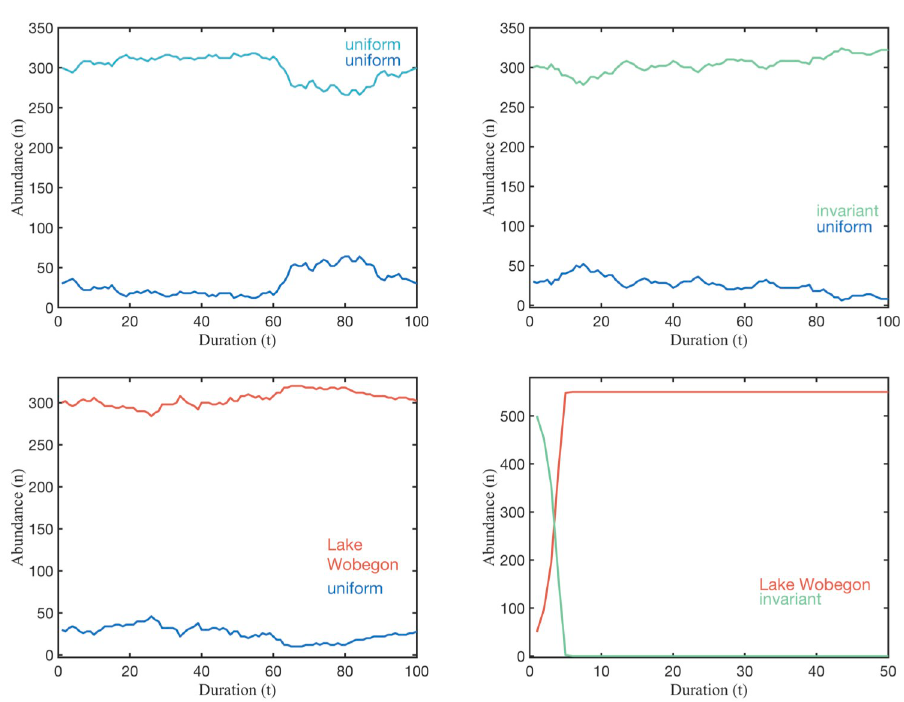
Fig 8. Phenotypic heterogeneity promotes infinite co-existence and thwarts invasion. The uniform distribution, an equilibrium strategy, persists even when their population abudance is vastly lower than their competitor’s. In contrast, the invariant strategy starting at a much higher population is quickly replaced by the Lake Wobegon strategy. Note that the mean competitive abilities of all strategies are identical.